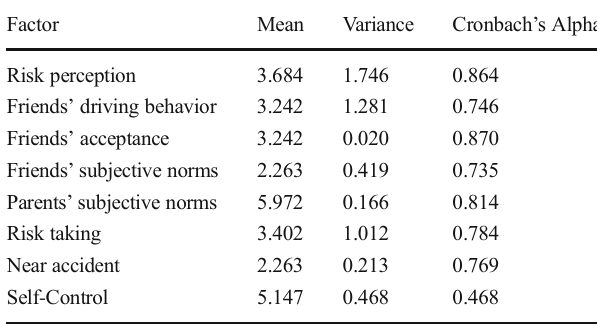
Summary of the factor